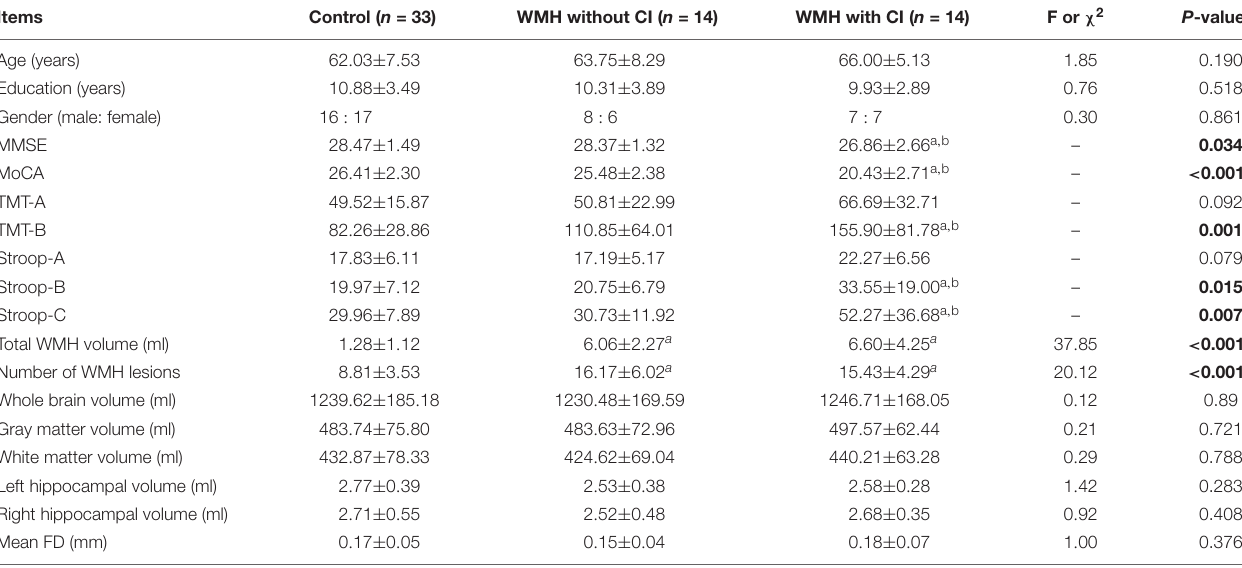
TABLE 1 | Demographic, neuropsychological and volume